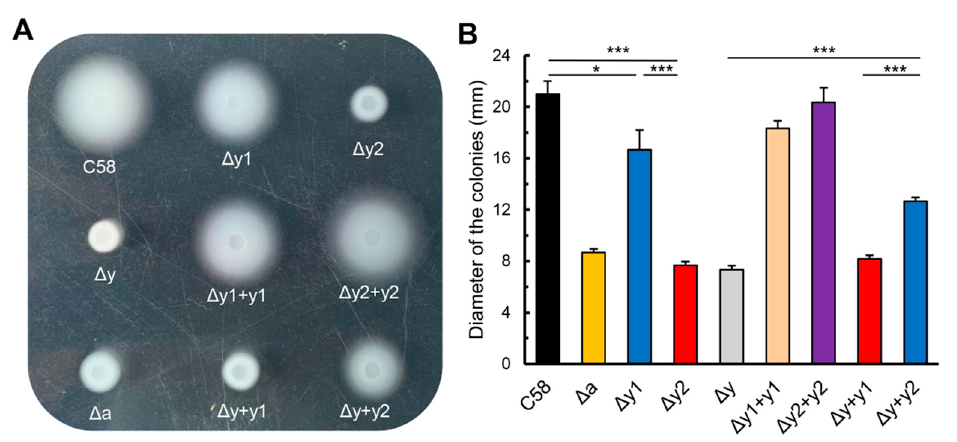
Figure 1. Chemotactic migration of cheY -deletion mutants and complemented strains of Agrobacterium fabrum in the swim plate. ( A ) Typical colonies of different A. fabrum strains after growing for 40 h on the swim agar plate. ( B ) Colony diameter of different A. fabrum strains after growing for 40 h on the swim agar plate. The data are the means of three independent replicates with standard deviations. The bars connected by “*” and “***” mark mean that they are different in a statistically significant manner at p < 0.05 and 0.001, respectively via the unpaired Student’s t test. C58, A. fabrum wildtype C58 strain; ∆ a, cheA -deletion mutant; ∆ y1, cheY1 -deletion mutant; ∆ y2, cheY2 -deletion mutant; ∆ y, cheY1 and cheY2 double-deletion mutant; ∆ y1 + y1, ∆ y1 mutant complemented with cheY1 gene; ∆ y2 + y2, ∆ y2 mutant complemented with cheY2 gene; ∆ y + y1, ∆ y mutant complemented with cheY1 gene; ∆ y + y2, ∆ y mutant complemented with cheY2 gene.